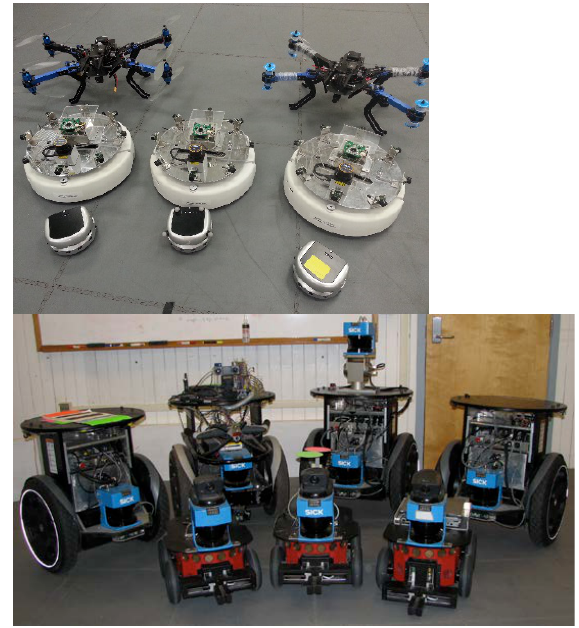
Figure 2: Unmanned-vehicle testbed at Penn State